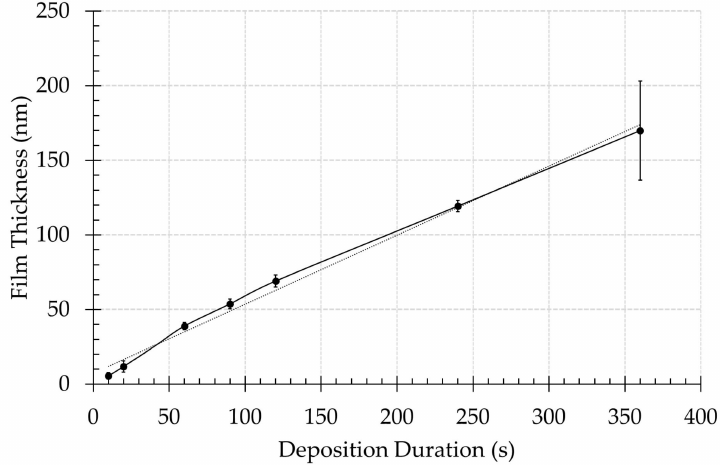
Figure 2. The evolution of the plasma-polymerized film thickness with plasma deposition